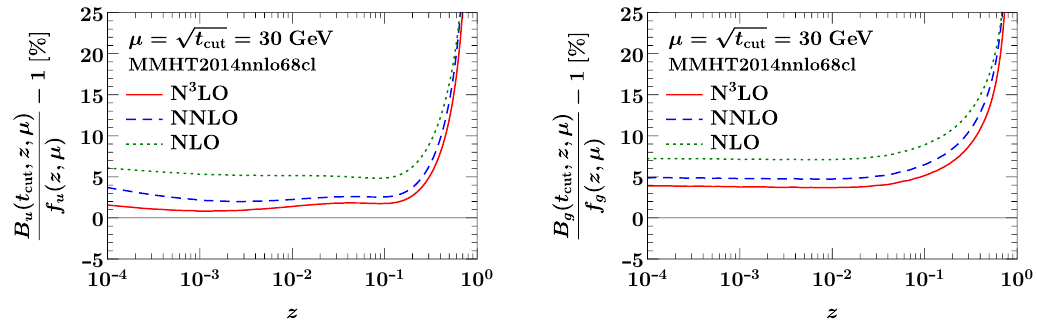
Figure 3 . The relative di(cid:11)erence of cumulative u -quark beam function (left) and the cumulative gluon beam function (right) to the corresponding PDF, as a function. We (cid:12)x (cid:22) = such that the shown beam function corresponds to the boundary term in a resummed